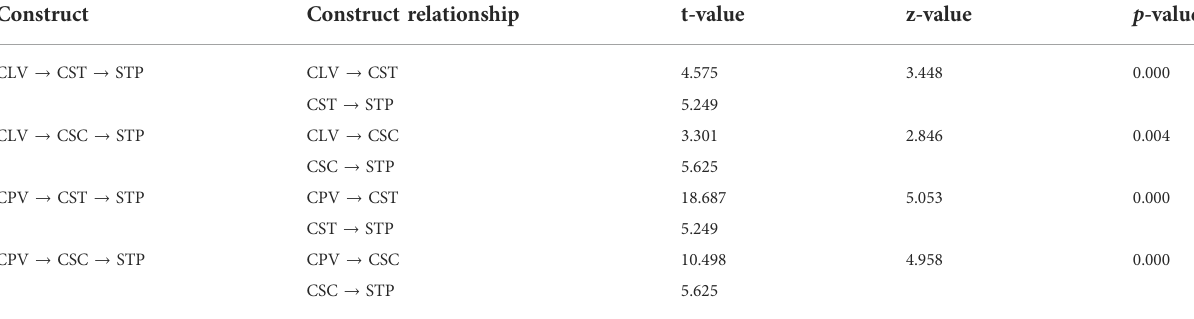
TABLE 7 Mediation test result. Construct Construct